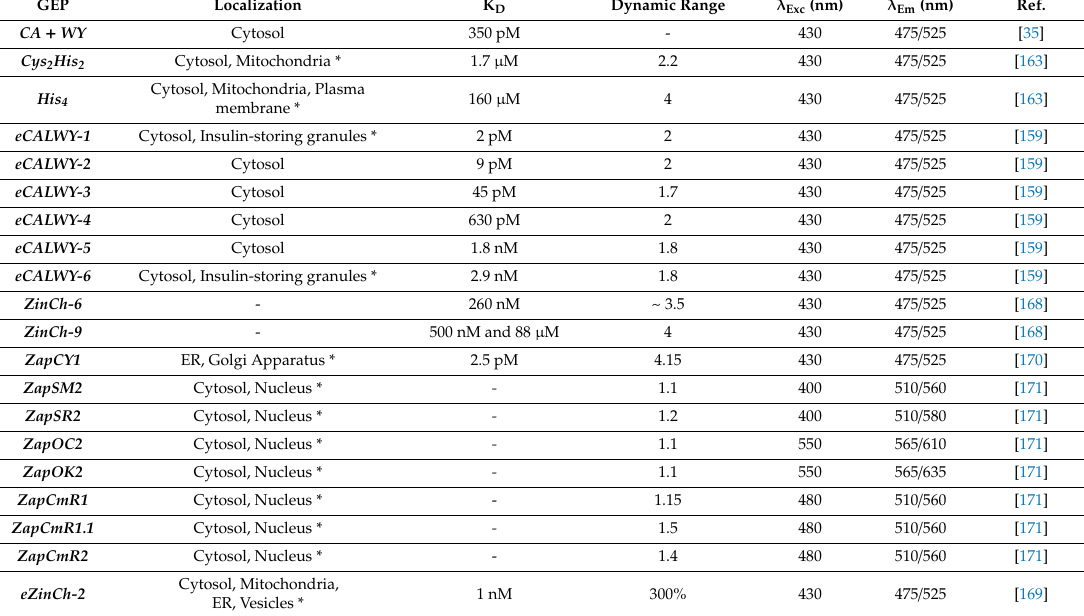
Table 5. Selection of FRET-based GEPs suitable for subcellular Zn 2 +